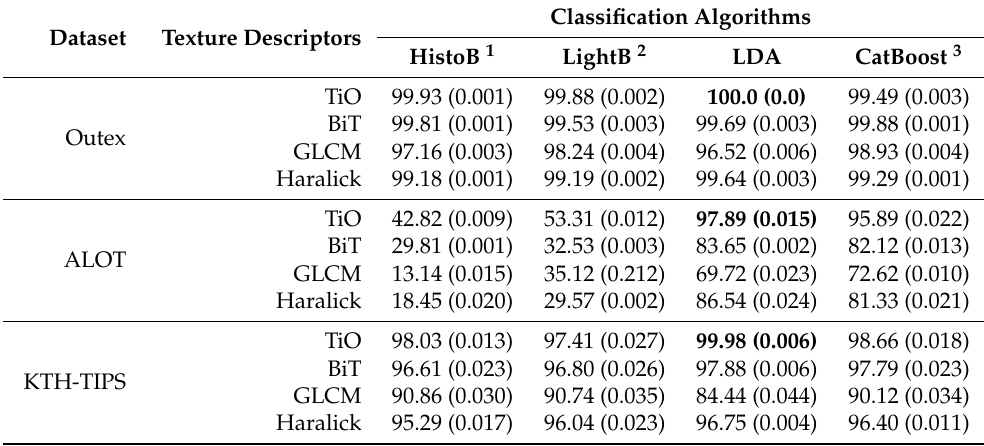
Table 2. Average accuracy and standard deviation (%) on the Outex, ALOT, and KTH-TIPS datasets using a 10-fold cross-validation setup. The best accuracy for each dataset is shown in boldface.